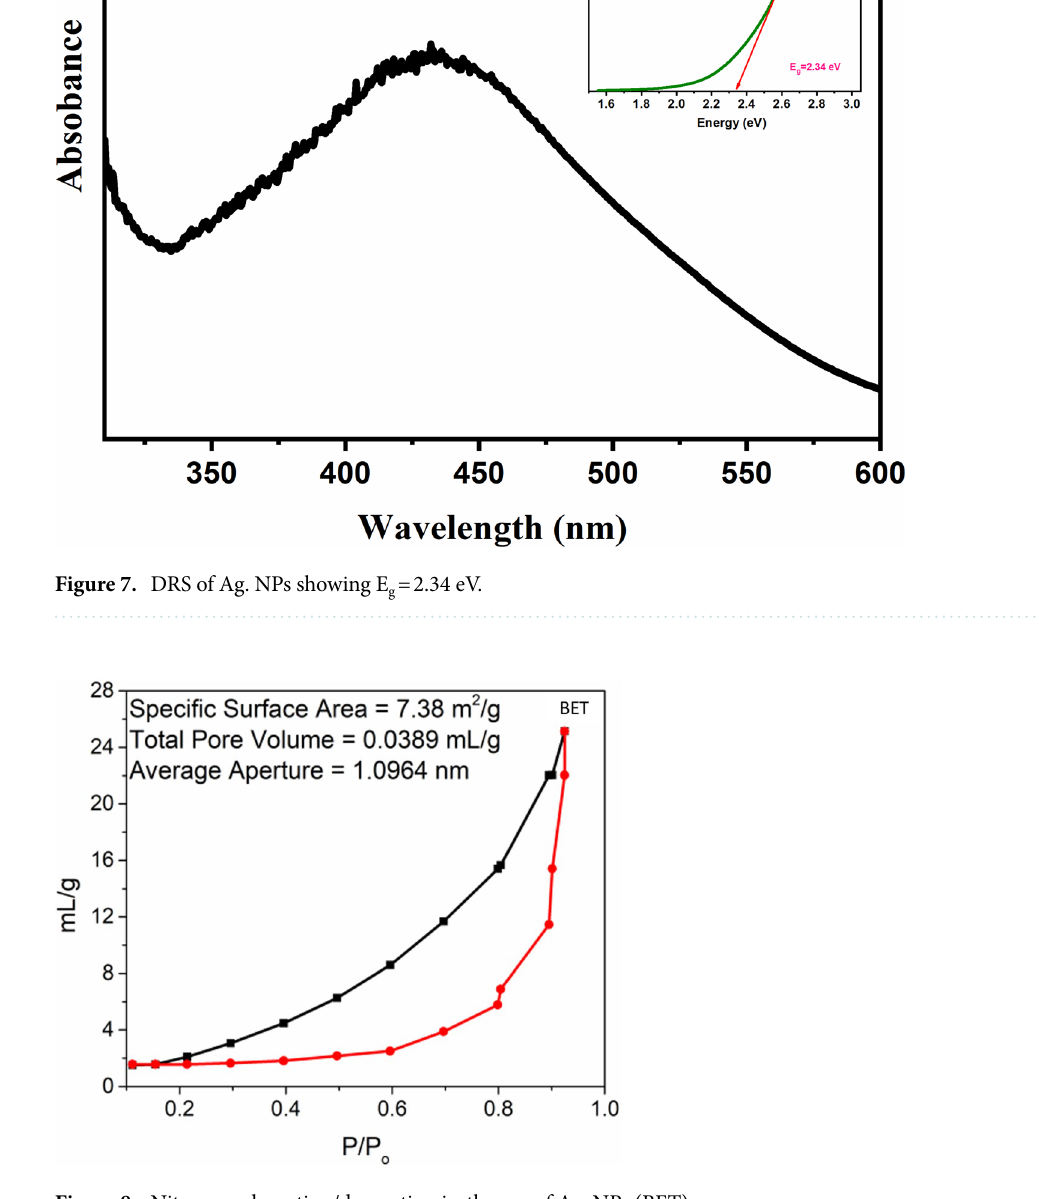
Figure 8. Nitrogen adsorption/desorption isotherms of Ag. NPs